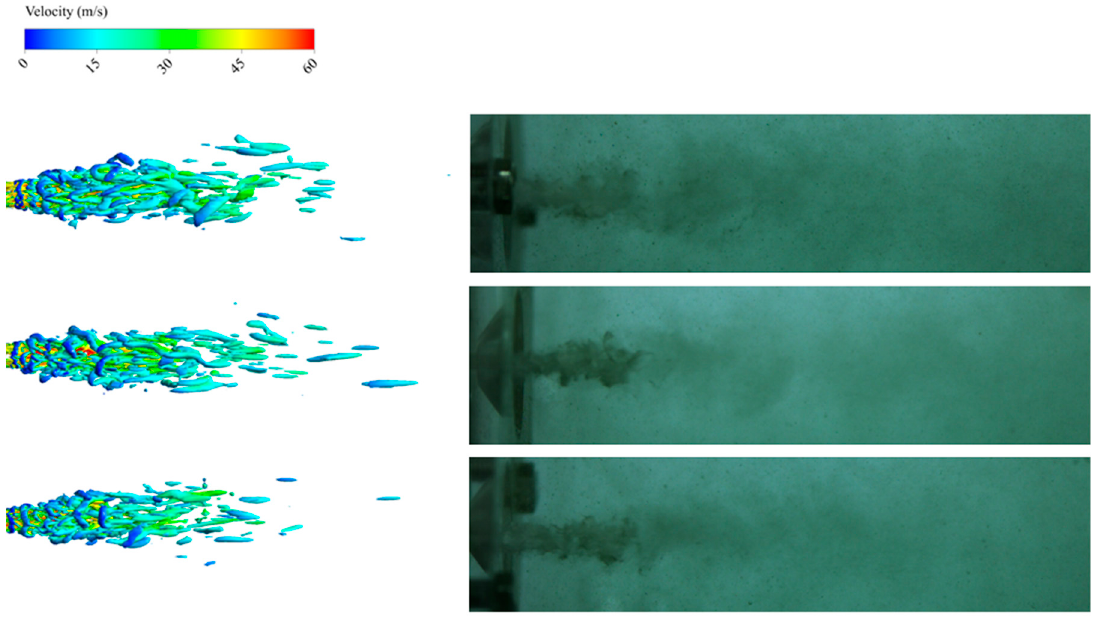
Figure 16. Coherent structure changing with cavity diameter (Q = 1.0 × 10 8 , L c / d 1 = 2, D c / d 1 = 6, 8, 10.).